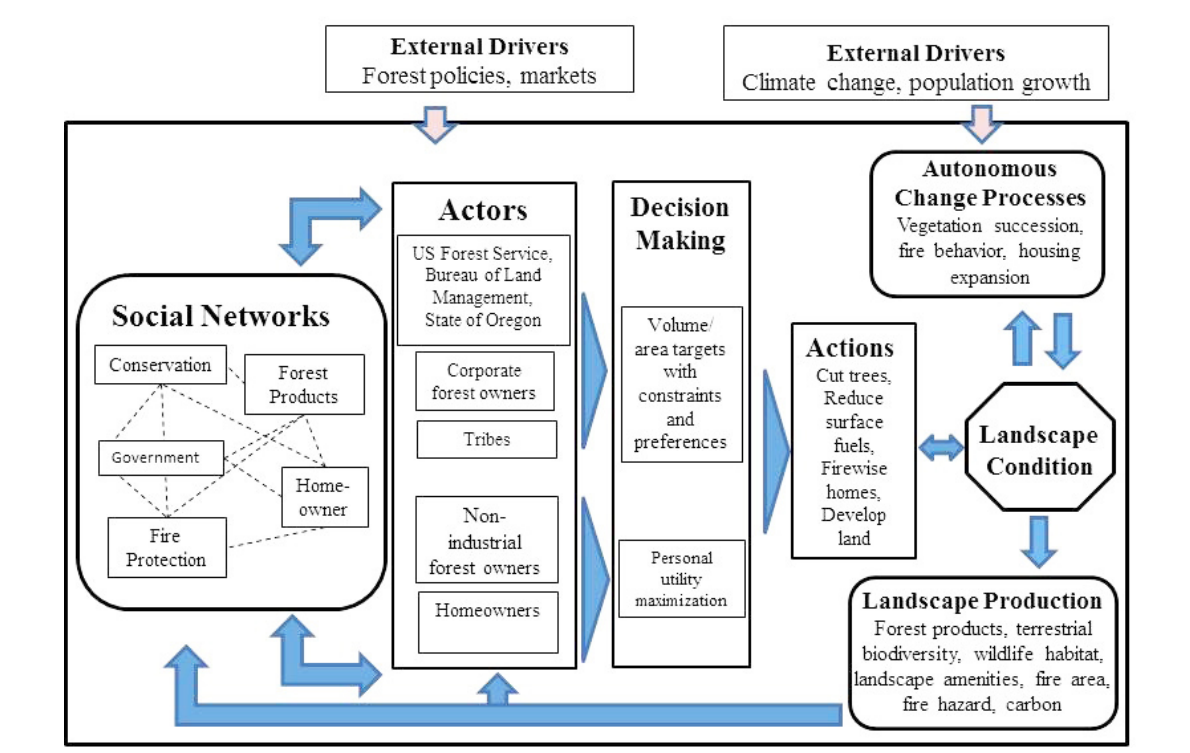
Fig. 4. Conceptual model of components and interactions in the coupled human and natural fire-prone system of central and south-central Oregon, USA. Landscape condition is the spatial representation of ecological and socioeconomic outcomes that is dynamic and feeds back to human perceptions, decision-making, and actions in the forest and at home